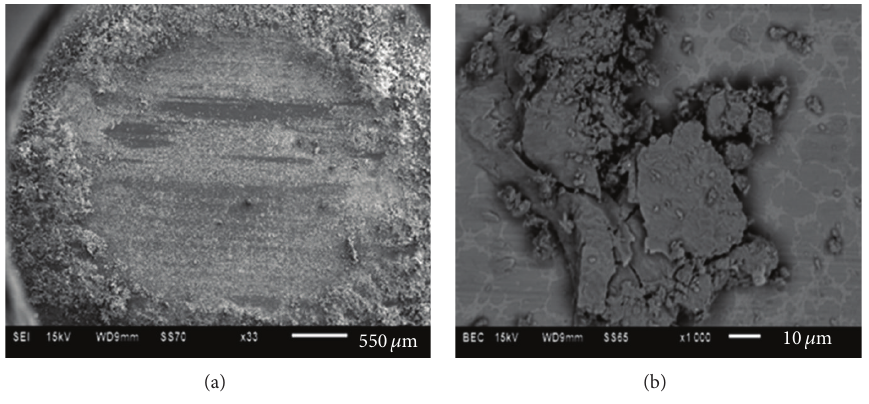
Figure 10: Wear track of the laser deposited Ni50Ti50 after sliding against a tungsten carbide ball.